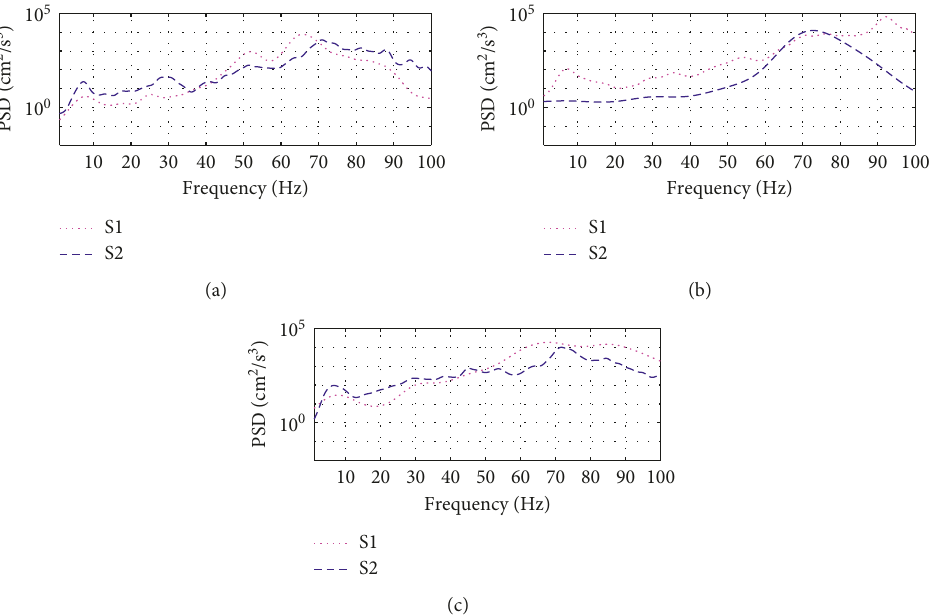
Figure 11: The smoothed average acceleration PSD of measured points S1 and S2 induced by subway. (a) X direction. (b) Y direction. (c) Z